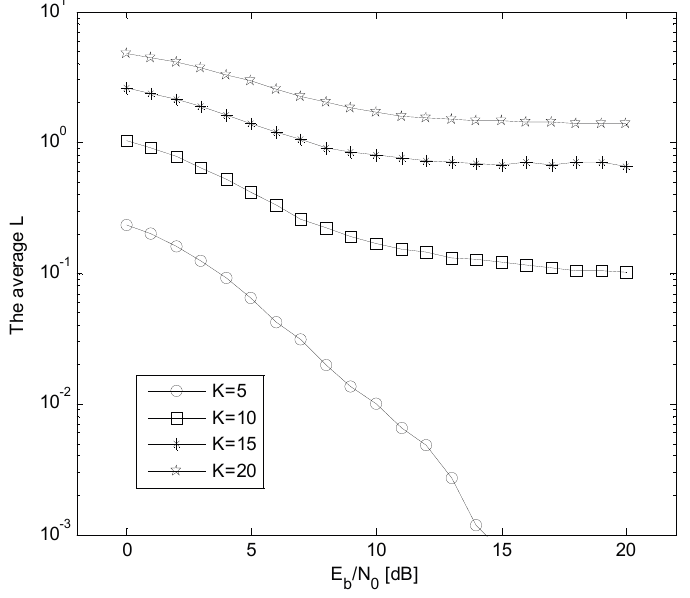
Figure 5. The average L versus E b / N 0 curves when K = 5, 10, 15, and 20 in AWGN